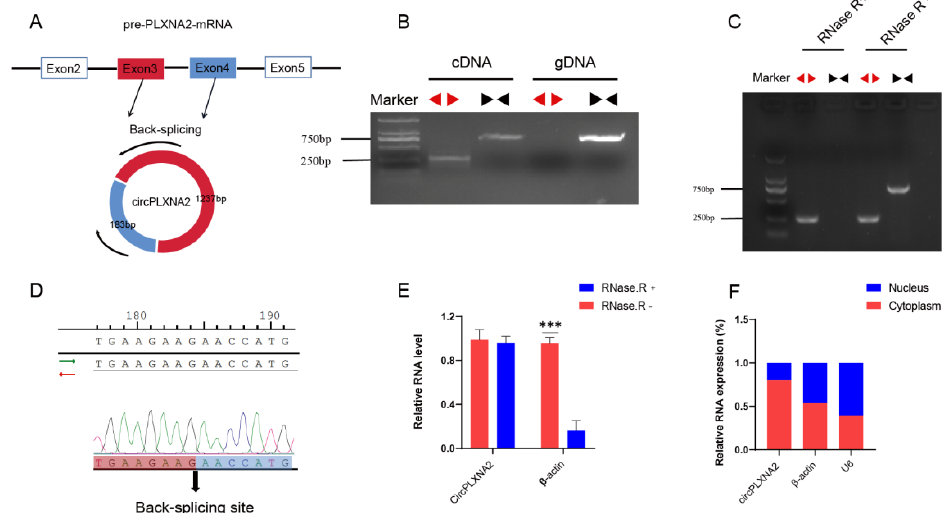
Figure 3. Identification of circPLXNA2 . ( A ) Schematic diagram of the cyclization of pre-PLXNA2- mRNA. ( B ) The divergent primers could only amplify circPLXNA2 in cDNA but not in gDNA, as visualized in the agarose gel electrophoresis. Black triangles represent convergent primers and red triangles represent divergent primers. ( C ) Convergent primers failed to amplify the target band with RNase R ‐ treated cDNA, whereas divergent primers could successfully amplify the target bands visualized in the agarose gel electrophoresis. Black triangles represent convergent primers and red triangles represent divergent primers. ( D ) Sanger sequencing confirmed the back ‐ splicing junction sequence of circPLXNA2 . ( E ) Relative mRNA expression of circPLXNA2 and β‐ actin after RNase R treatment. (F) The location of circPLXNA2 in the cytoplasm and nucleus of CPM was analyzed by qRT ‐ PCR. GAPDH and U6 were served as cytoplasmic and nuclear localization controls, respectively (*** p < 0.001).